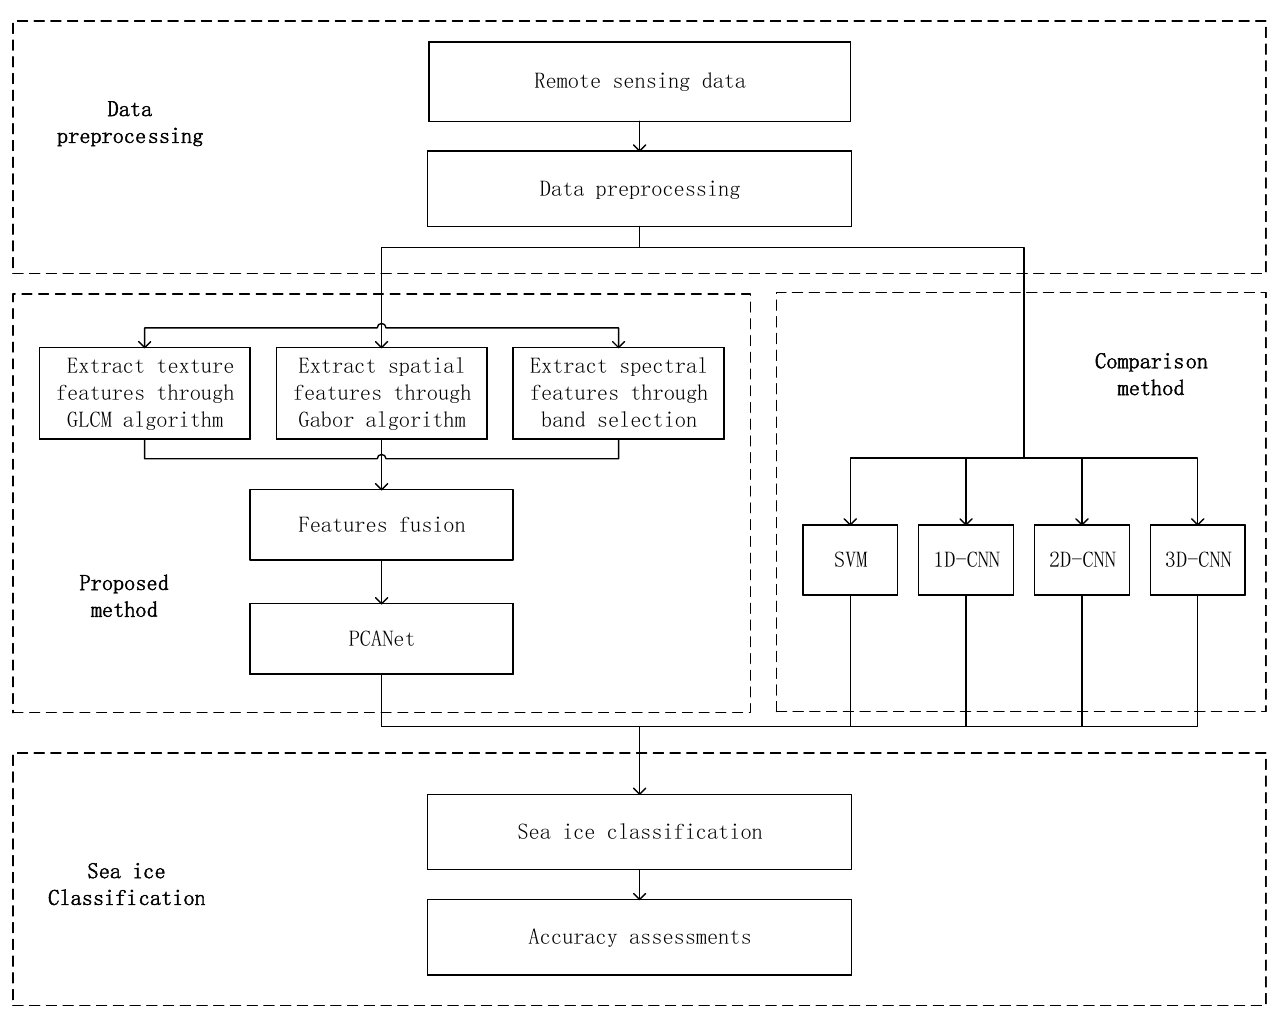
Figure 1. The structure of the proposed framework.